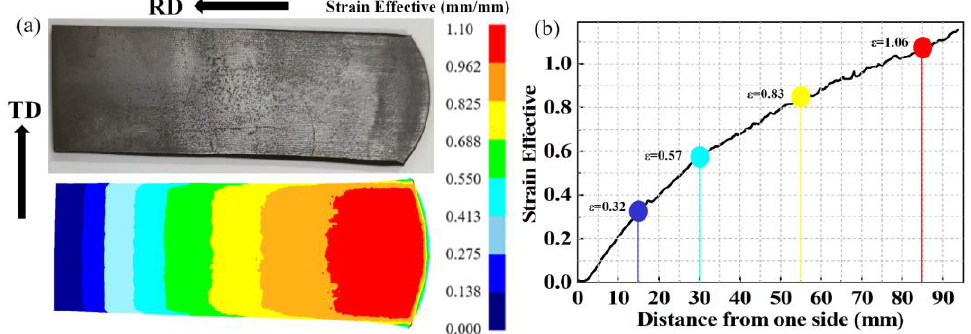
Figure 4. ( a ) The wedge-shaped hot-rolled sheet and its corresponding strain distribution on the mid-thickness plane; ( b ) specific strain value in observation areas.